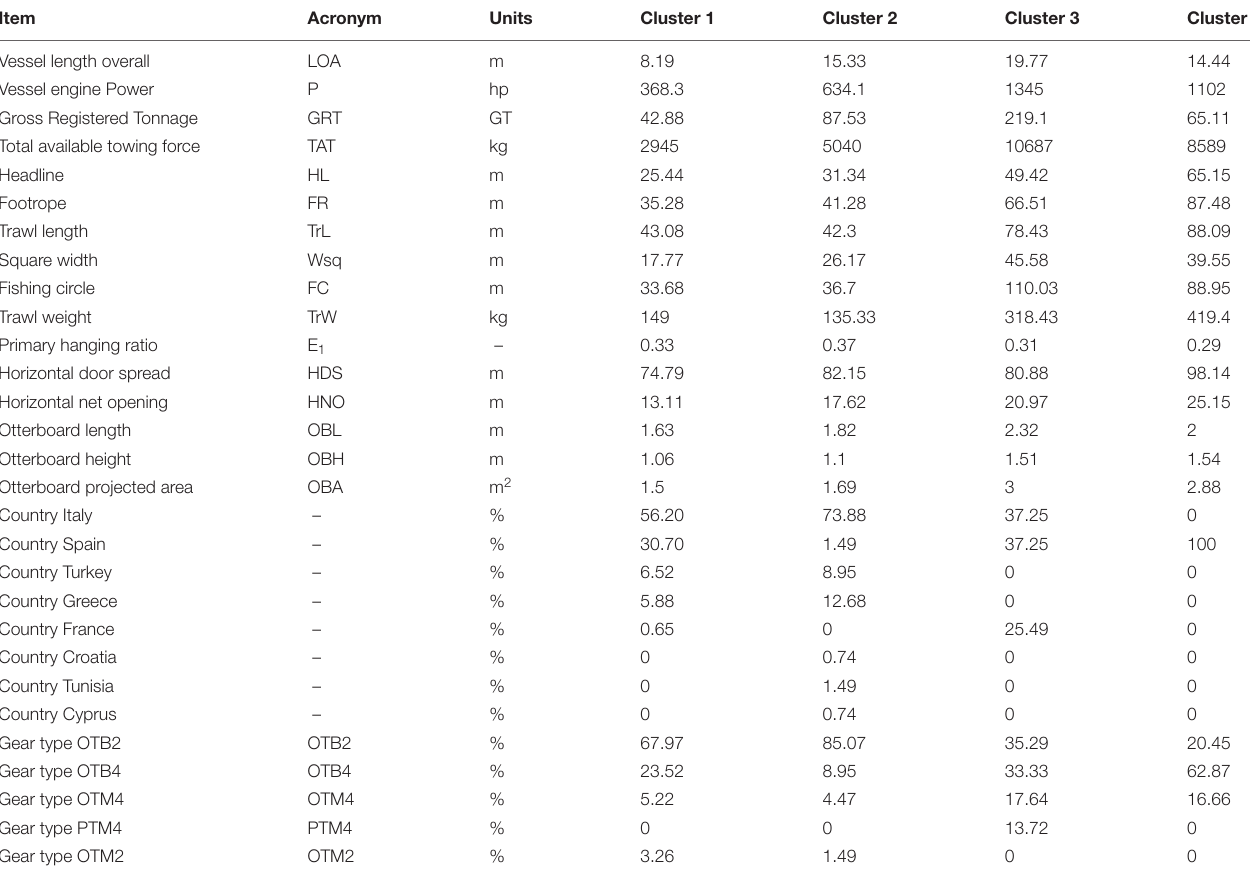
TABLE 3 | Summary table of the observed statistics for the identified clusters.